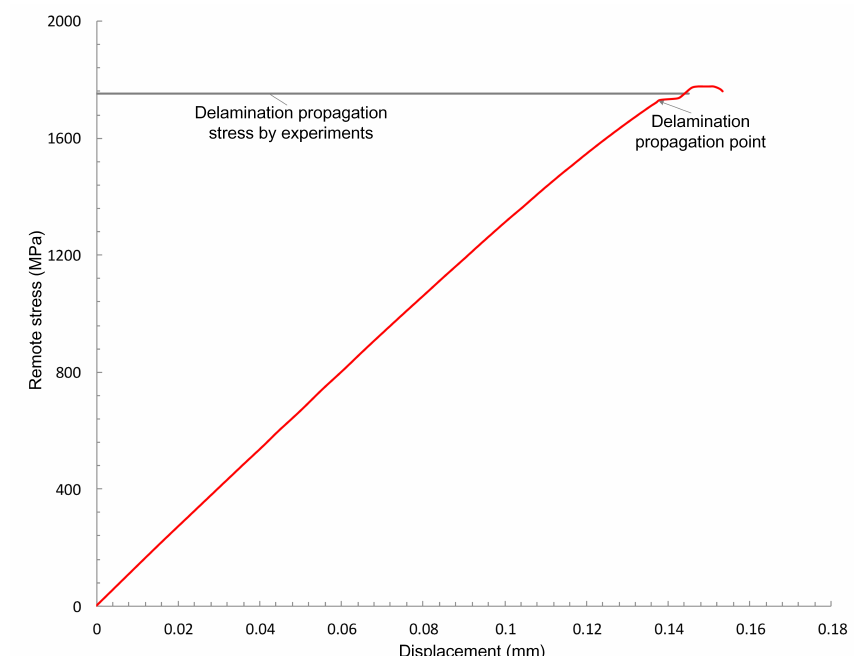
Figure 6. The predicted remote stress-displacement